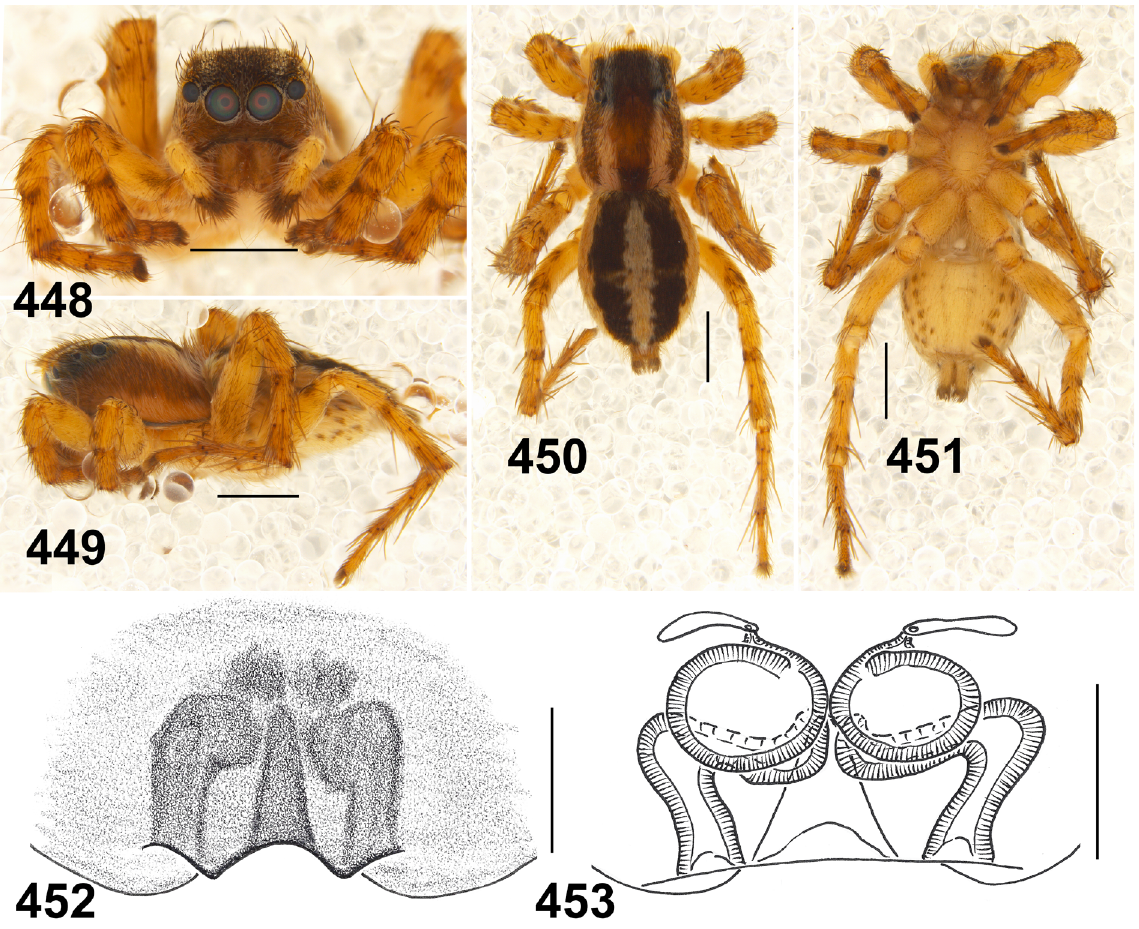
Figs 448–453. Stenaelurillus sudanicus Wesołowska, 2014, holotype, ♀ . 448–451 . General appearance. 452 . Epigyne, ventral view. 453 . Spermathecae, dorsal view. Scale bars: 448–451 = 1 mm; 452–453 = 0.1